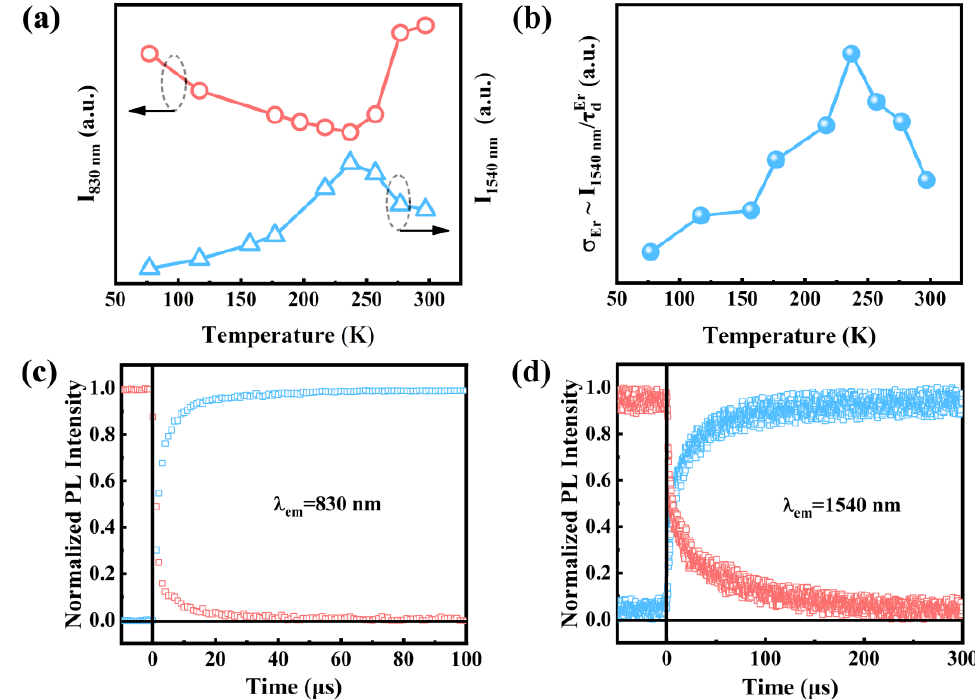
Figure 5. ( a ) Temperature dependence of the integrated PL intensity. ( b ) Temperature dependence of 𝜎 𝐸𝑟 ~𝐼 1540 𝑛𝑚 /𝜏 𝑑𝐸𝑟 . PL rise time and decay time for ( c ) Si QDs (830 nm) and ( d ) Er 3+ (1540 nm) at a pump power of 2 mW.